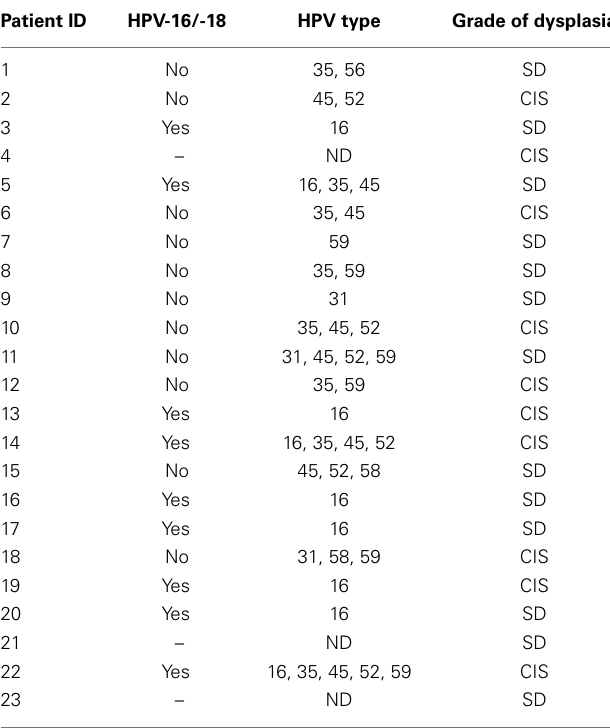
Table 3 | Human papillomavirus types by grade of dysplasia